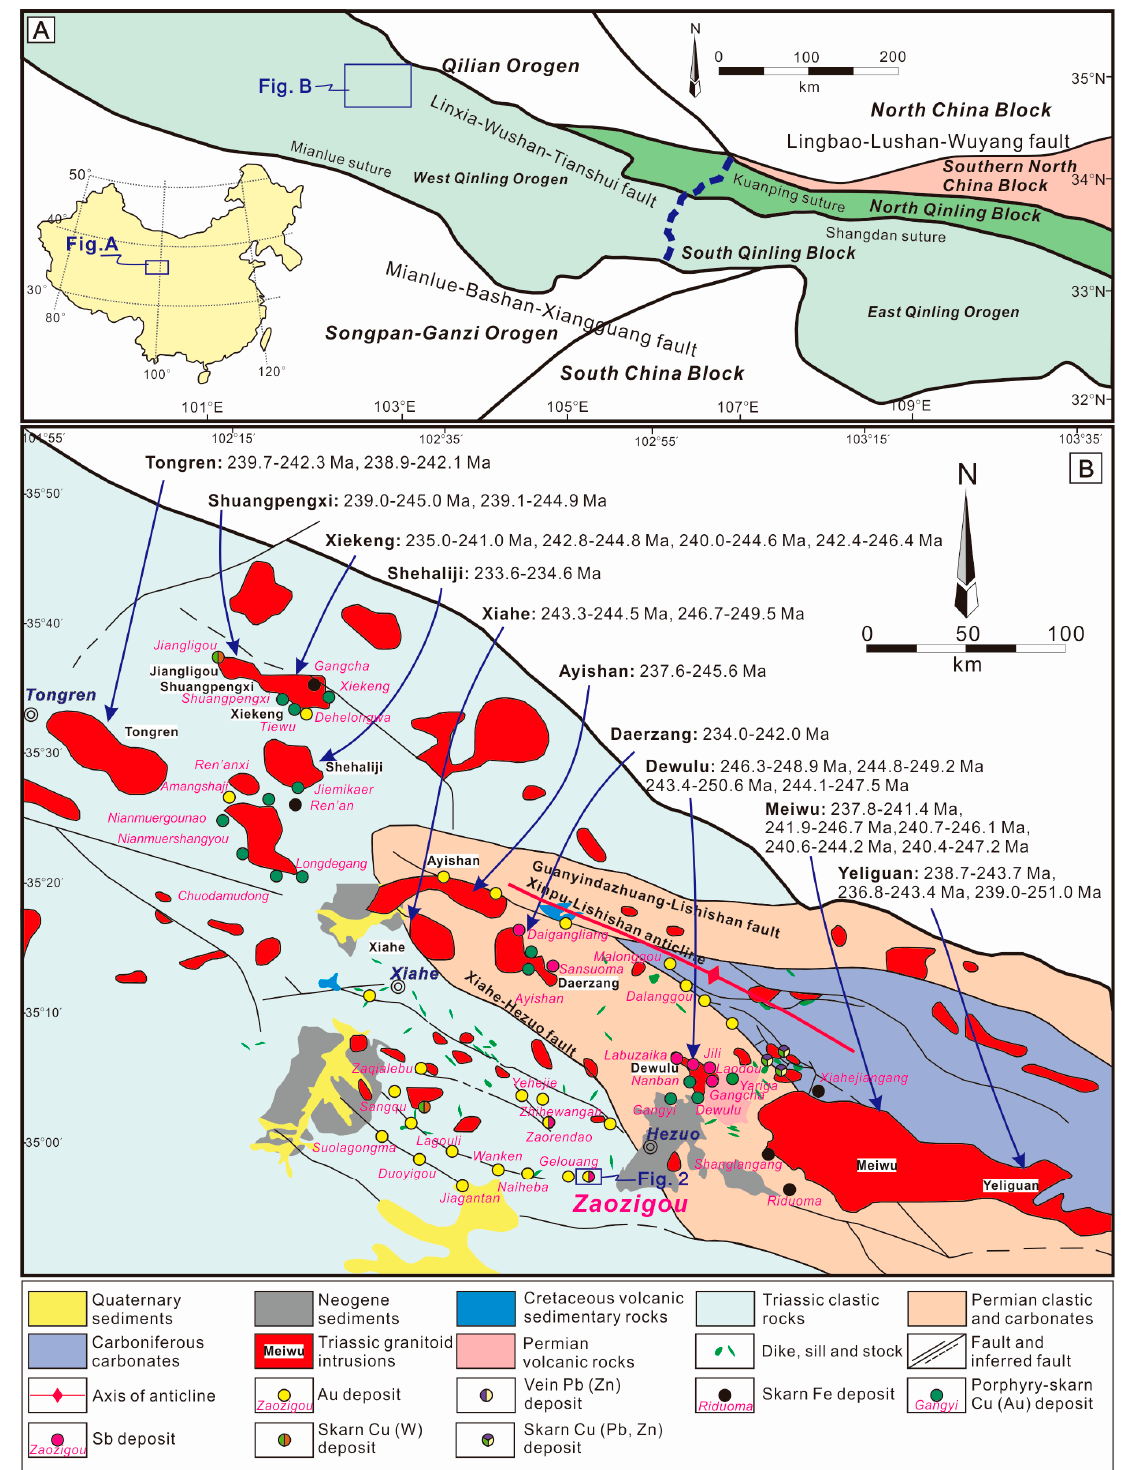
Figure 1. ( A ) Major tectonic domains of China and the location of the Qinling Orogenic Belt. Inset shows the location of the study area (modified after [6]). ( B ) Simplified geological map of the Tongren–Xiahe–Hezuo area of the Western Qinling Orogen, showing distributions and ages of early Triassic granitoids and ore deposits (modified after [6]).